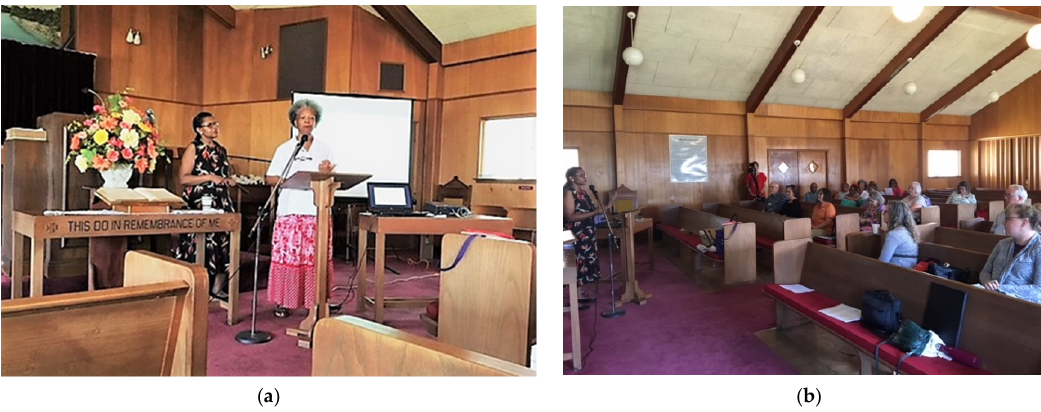
Figure 2. The CLG Workshop, held August 1, 2018, was co-hosted by the stat CLG program, the County Historical Commission, and the local Edwards Association—an African American group dedicated to the preservation of a historic African American School in Gonzales. The images show participation in a storytelling exercise ( a ) and the author leading the workshop through a self-assessment exercise to be performed in small groups ( b ).